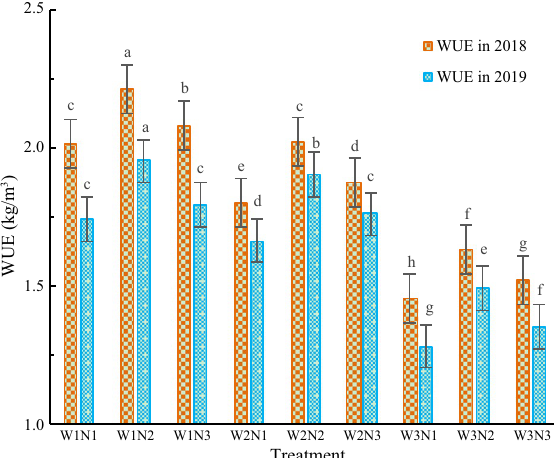
Figure 6. The effects of the different treatments on the WUE of Isatis indigotica . The values shown are the mean ± SD, n = 3. Asterisks indicate a significant difference at the P ≤ 0.05 level.